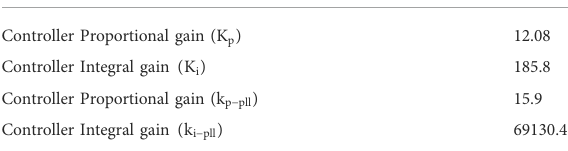
TABLE 5 Control parameters.